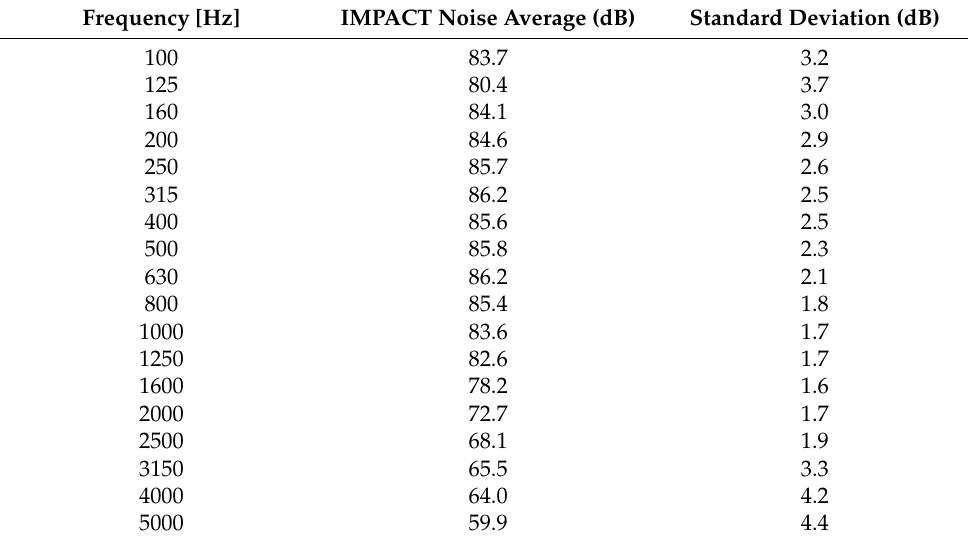
Table 3. Average trend and standard deviation of averaged impact sound pressure levels (tapping machine).